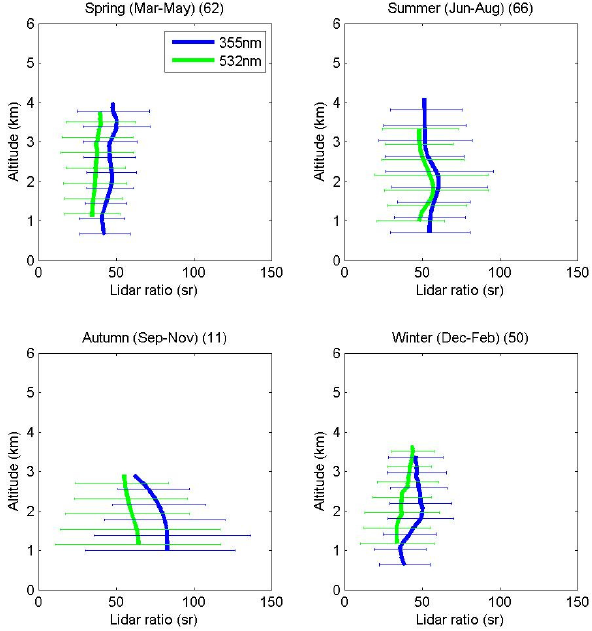
Fig. 5. Seasonal averaged lidar ratio profiles for 355nm (blue) and Figure 5. Seasonal averaged lidar ratio profiles for 355nm (blue) and 532 nm (green) with 532nm (green) with standard deviations. The value in the plot title standard deviations. The value in the plot title indicates the number of profiles used in indicates the number of profiles used in calculations for each season. calculations for each season.